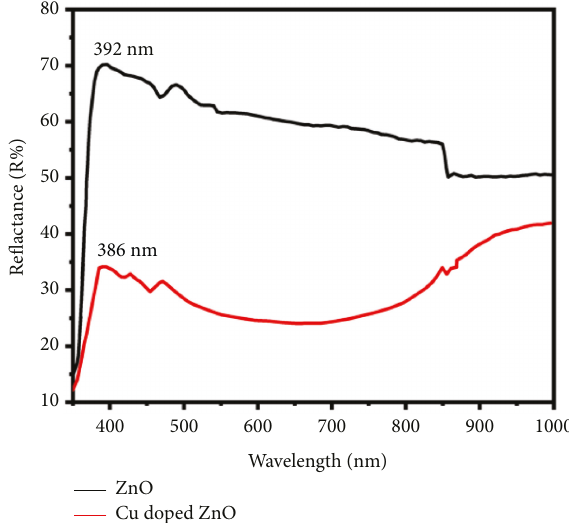
Figure 6: DRS spectra of pure and Cu-doped ZnO